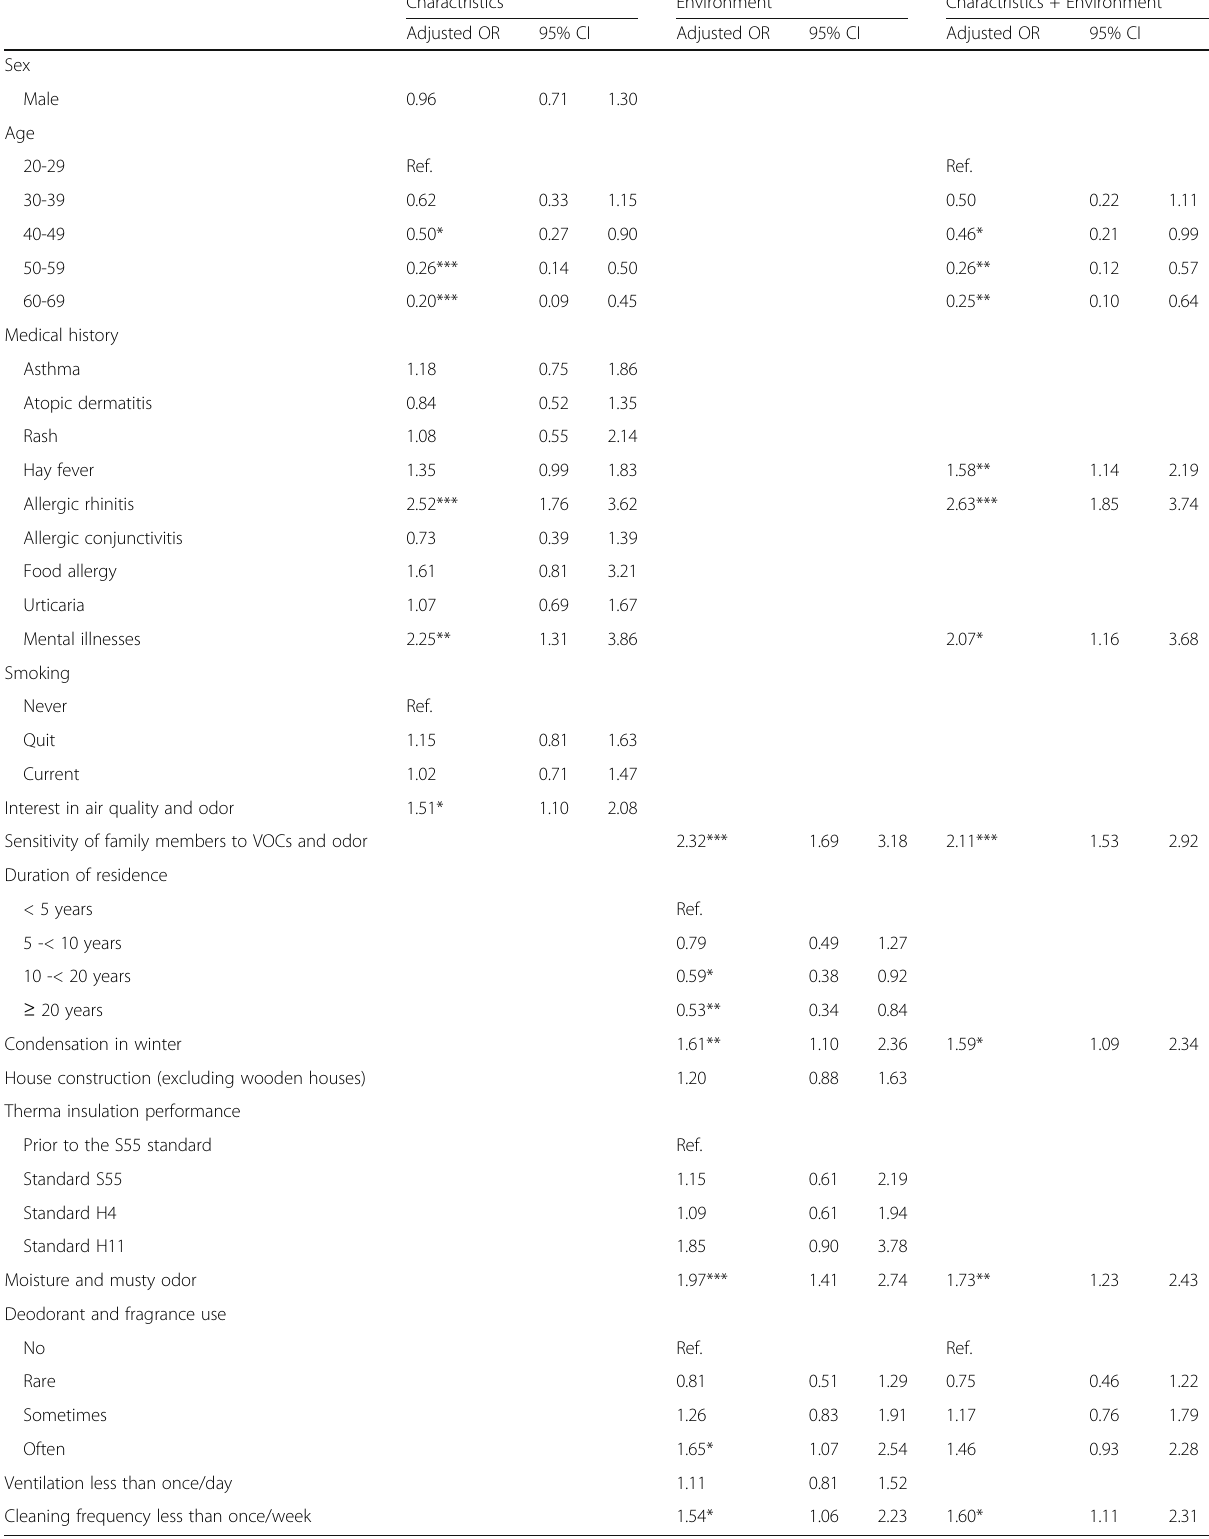
Table 3 Results of univariate and multivariate regression analyses for the association of objective variables with pre-SBS Charactristics Environment Charactristics +